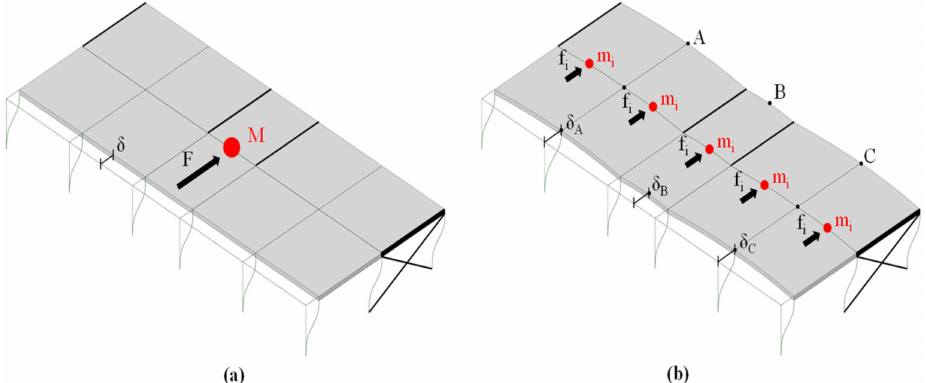
Figure 6. Lateral maximum displacement ( δ ): average value ( a ) and individual recorded in each bay ( b